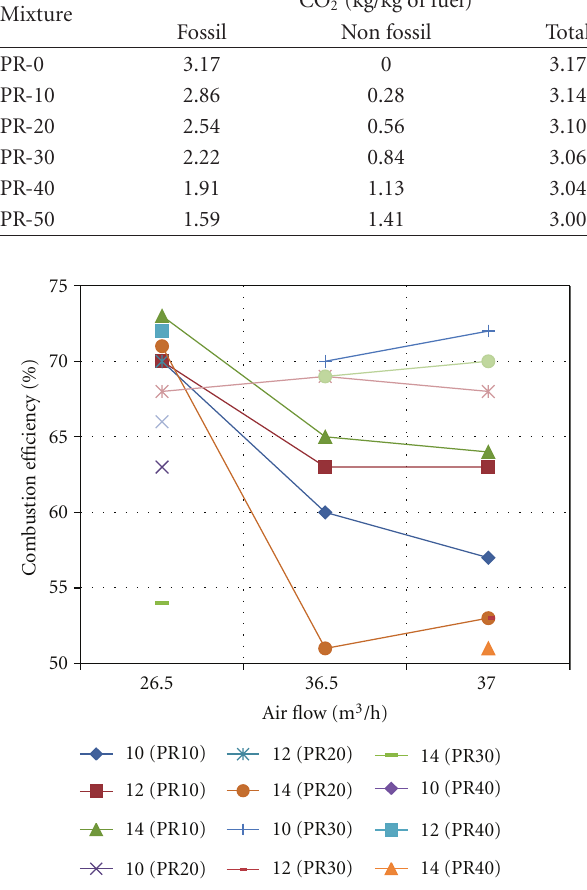
Figure 6: Variation in performance depending on mixture percent- age, injection pressure, and air flow.